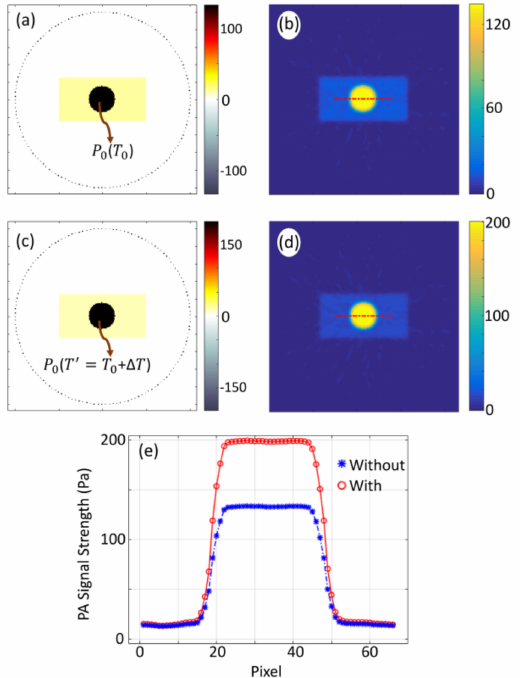
Figure 1. Representative images of initial pressure distribution of the tissue-mimicking numerical sample with a circular target being embedded in the background and sensor array distributed over a circular ring ( a , c ). Numerical samples with circular targets at a temperature T 0 ( a ), and temperature T (cid:48) = T 0 + ∆ T ( c ). The corresponding reconstructed images ( b ) for target at a temperature T 0 and ( d ) for target at temperature T (cid:48) obtained using k-wave MATLAB toolbox. ( e ) Variation of PA-signal strength along the marked lines shown in ( b , d